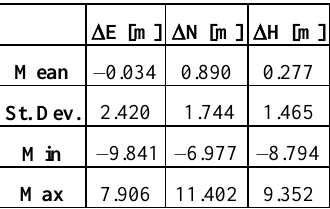
Table 1 Summary of horizontal and vertical